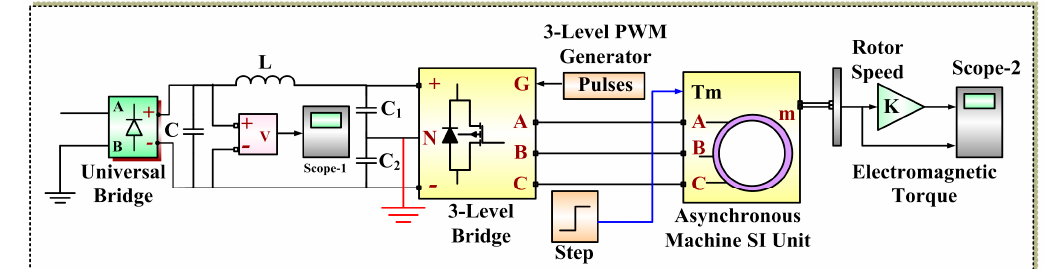
Figure 5. Simulink model of the three phase EV motor.